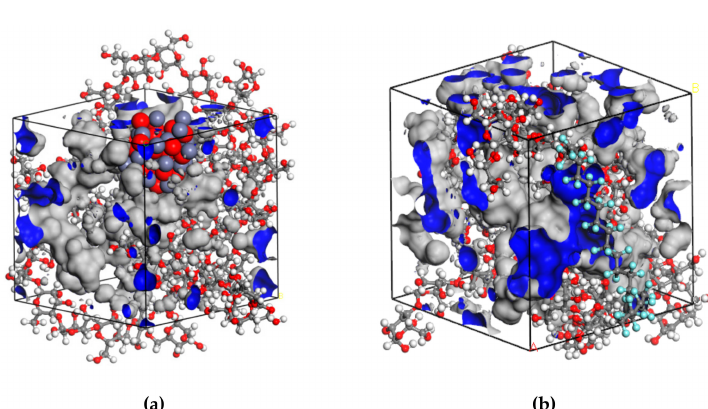
Figure 5. RF magnetron sputtering functional film on the surface of the cellulose